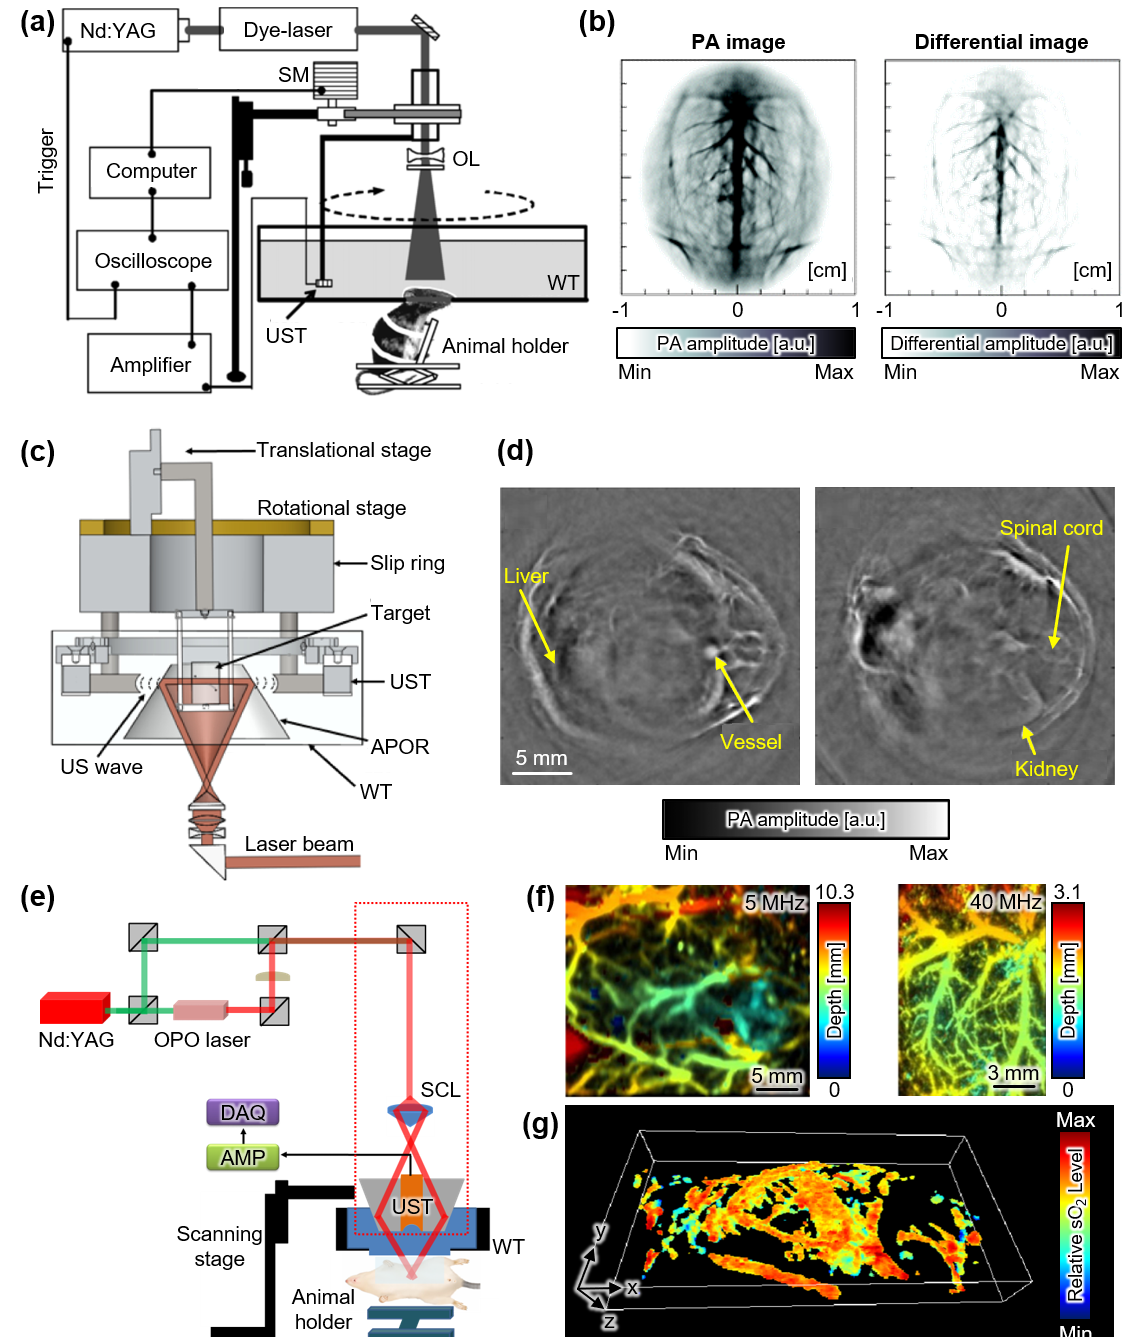
Figure 1. PAI systems with single ‐ element USTs. ( a ) Schematic of PAI system with circular scanning of a single ‐ element UST. ( b ) Contrast ‐ enhanced PA and differential images of the brain of a rat with an injection of contrast agent. ( c ) Schematic of PAI system with a slip ‐ ring ‐ based rotational scanning using multiple USTs. ( d ) PA images of abdomen region of mice in vivo. ( e ) Schematic of PAI system with raster scanning using a single ‐ element UST. ( f ) PA images with two different UST center fre ‐ quencies. ( g ) Volumetric sO 2 whole ‐ body distribution in mice in vivo. PA, photoacoustic; PAI, pho ‐ toacoustic imaging; UST, ultrasound transducer; sO 2 , hemoglobin oxygen saturation; SM, step mo ‐ tor; OL, optical lens; WT, water tank; APOR, acoustically penetrable optical reflector; AMP, ampli ‐ fier; DAQ, data acquisition module; SCL, spherical conical lens. The images are reproduced with permission from refs. [23,25–27].